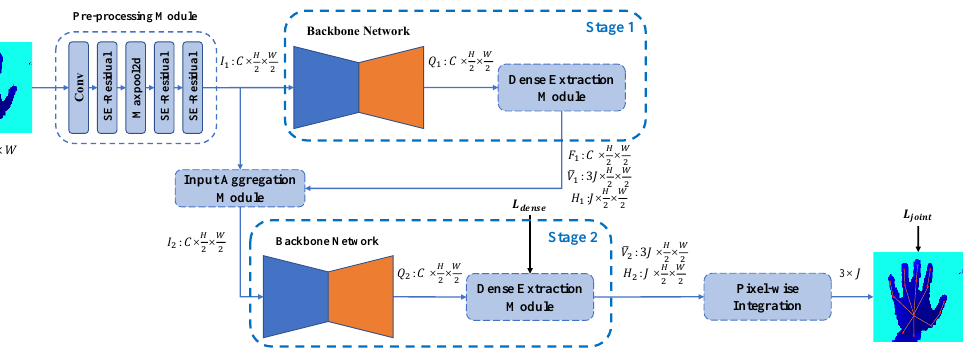
Figure 2. The working pipeline of the proposed SARN. The input of SARN is a depth image of size 1 × H × W , and the output is the 3D position of J hand keypoints, which has a size of 3 × J . H and W represent the height and weight of the input depth image. Pre-processing module extracts C feature × W maps of size H from the input depth image. SE-Residual is a variant of the residual block [31]; 2 2 we will introduce its structure in Section 3.3. I i and Q i stand for the input features and output of the backbone network at stage i . V i and H i denote the dense representation predicted by the dense extraction module at stage i . For I i , Q i , V i , and H i , i = 1,2. F 1 is an intermediate feature in the dense extraction module at the first